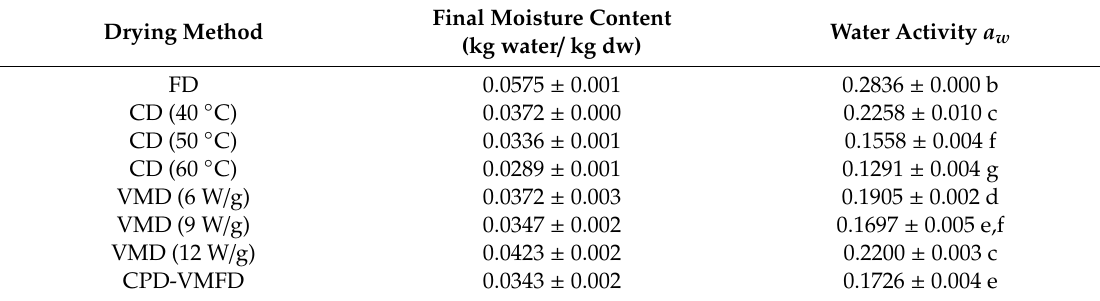
Table 1. Final moisture content and water activity of dried C. alata dehydrated using di ff erent methods. Drying